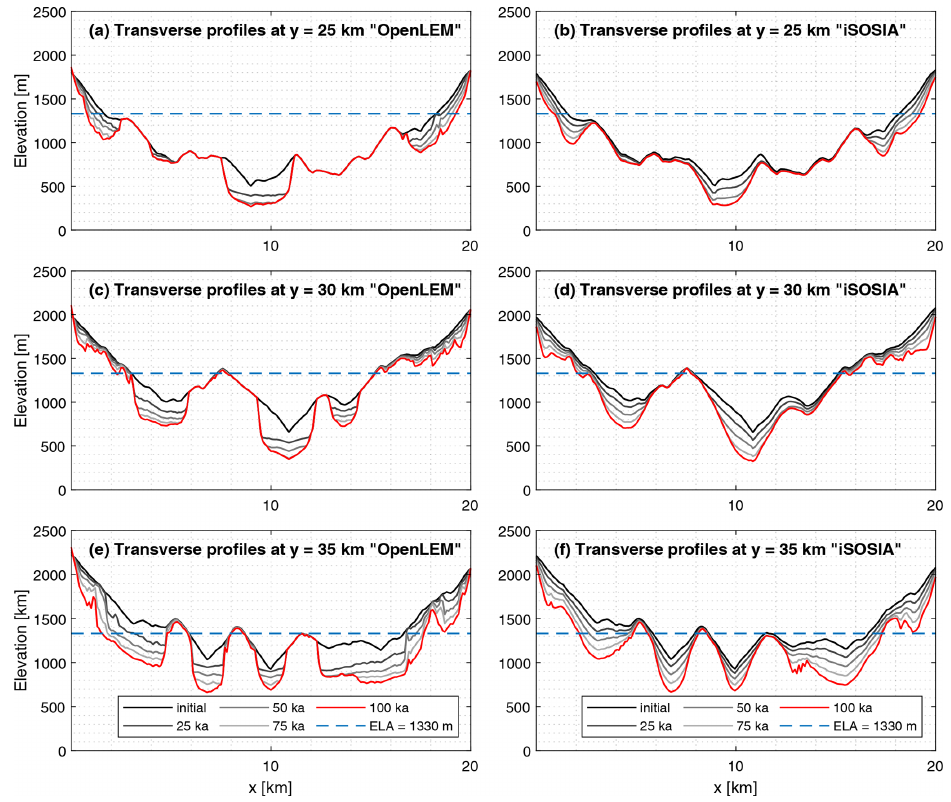
Figure B3. Time series of the evolution of the transverse profiles in the iSOSIA and OpenLEM experiment (Sect. 3.2) at different positions upstream of the